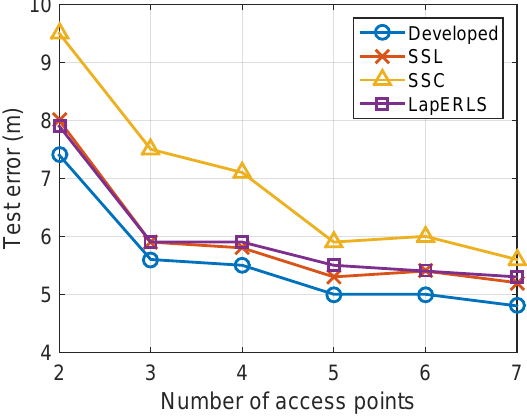
Figure 11. Impact of the number of Wi-Fi access points for localization performance.